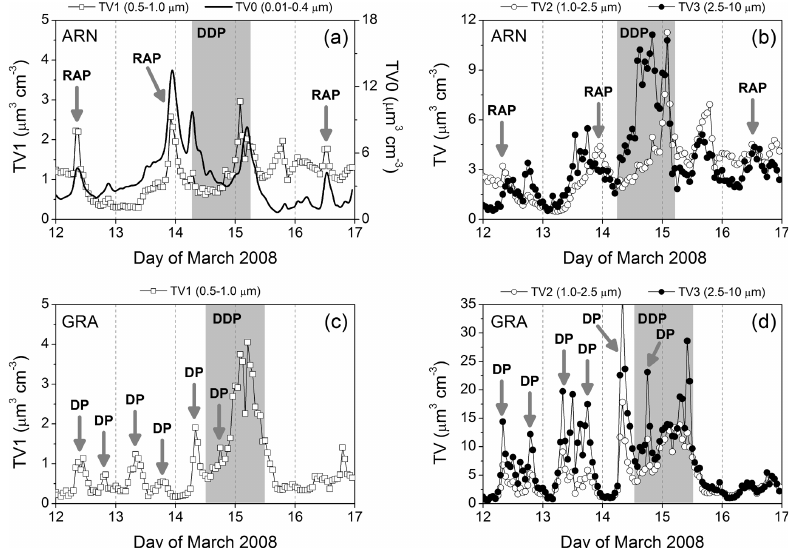
Fig. 11. Temporal evolution of the total volume (TV) particle concentration (hourly integrated) for four discrete size ranges: 0.01–0.4µm (TV0), 0.5–1.0µm (TV1), 1.0–2.5µm (TV2) and 2.5–10.0µm (TV3) for the overall period of 12–16 March 2008, in both ARN ( a and b ) and GRA ( c and d ) sites. Selected aerosol episodes are marked by grey arrows (Regional Anthropogenic Plume, RAP, and Diurnal Pattern, DP) and shaded area (Desert Dust Plume, DDP) in each